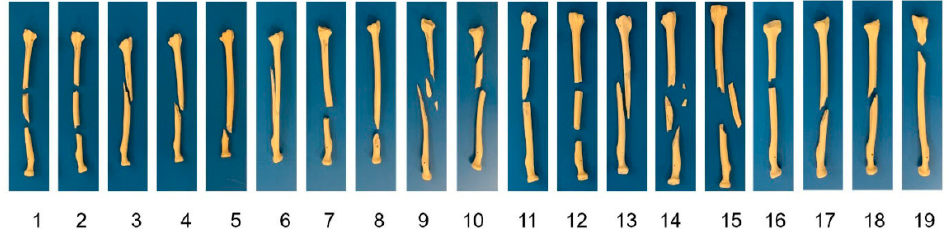
Figure 1. Experimental fracture models for 19 ORTHObone tag numbers. The simple fractures (11 cases) involved only two fragments, while the comminuted fractures (8 cases) involved three or more fragments. Each classification included both transverse fractures (4 cases) and spiral fractures (15 cases).